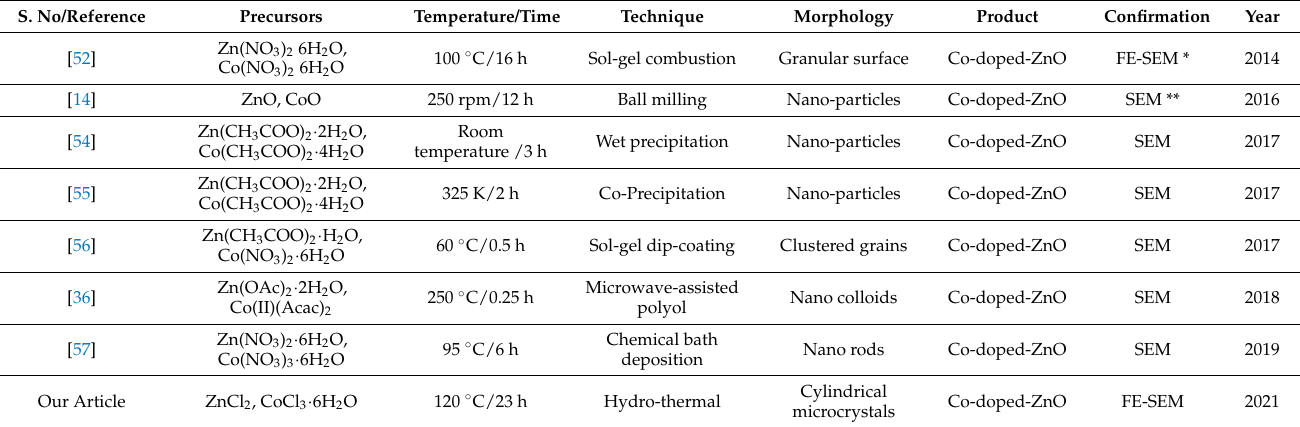
Table 1. Comparison of the experimental procedure and other parameters of Co-doped ZnO-MCs with the literature. S.